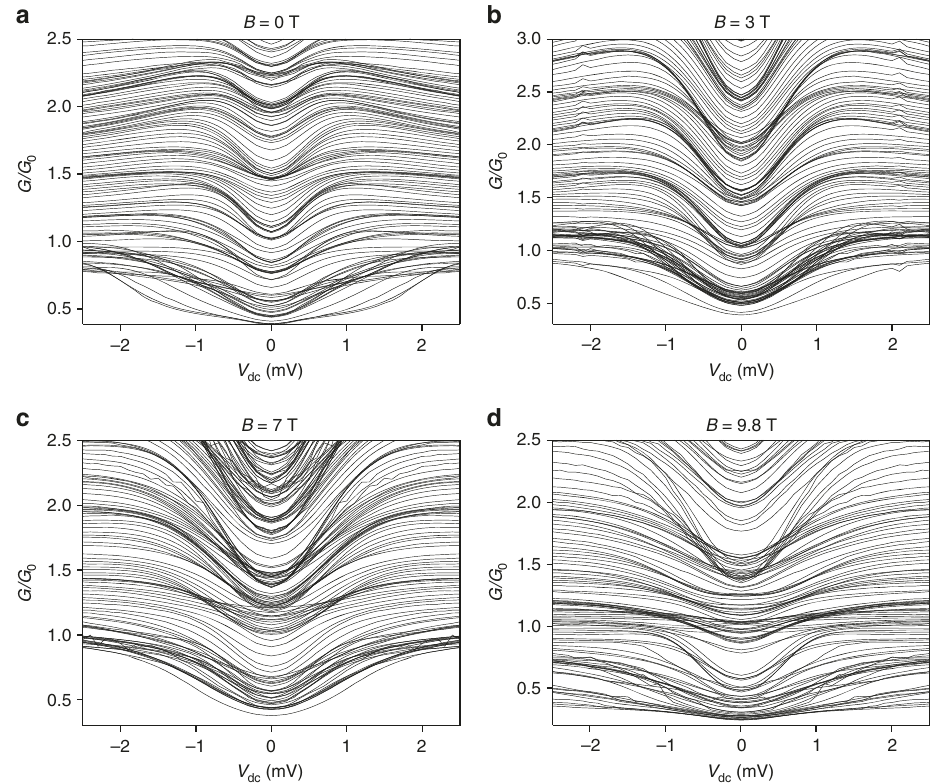
Fig. 5 Traces of the differential conductance G as a function of the applied V dc for different split-gate voltages. a The split-gate voltage was decreased by 20 mV between successive V dc sweeps from − 5.16 to − 7.6 V. No magnetic fi eld was applied. b The split-gate voltage was decreased by 15 mV between successive V dc sweeps from − 5.64 to − 7.5 V. A magnetic fi eld of 3 T was applied perpendicularly to the 2DEG. c The split-gate voltage was decreased by 15 mV between successive V dc sweeps from − 5.5 to − 7.45 V. A magnetic fi eld of 7 T was applied perpendicularly to the 2DEG. d The split-gate voltage was decreased by 9 mV between successive V dc sweeps from − 6.548 to − 7.7 V. A magnetic fi eld of 9.8 T was applied perpendicularly to the 2DEG